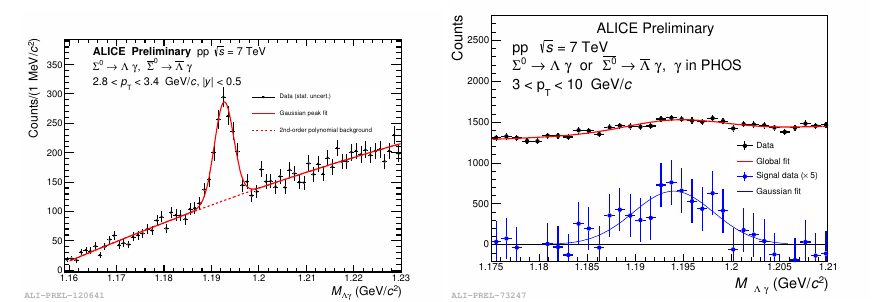
Figure 1. Invariant mass of Λ γ and ¯ Λ γ pairs, where the Λ or ¯ Λ is detected in the central tracking system and the photon is detected using the conversion method (left) or PHOS (right). The red curves are fits to the data using Gaussian peaks plus third-order polynomials to describe the background. The invariant mass distribution after the background subtraction is presented on the bottom part of the right plot.